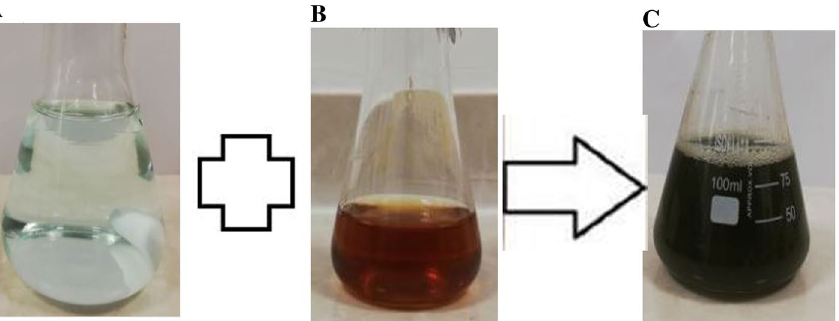
Figure 1. Color change assay for validation of CuONPs synthesis. ( A ) CuSo4 solution, ( B ) Supernatant of Bacillus coagulans , ( C ) biosynthesized CuONPs using Bacillus coagulans